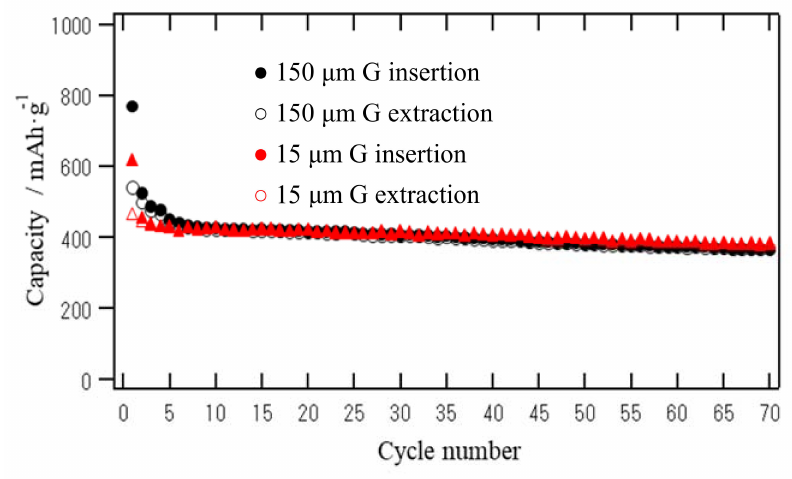
Figure 2. Cyclic performances of the Si/G/CP electrode with 16 wt % and 5 µ m Si at 100 mA g − 1 and 25 ◦